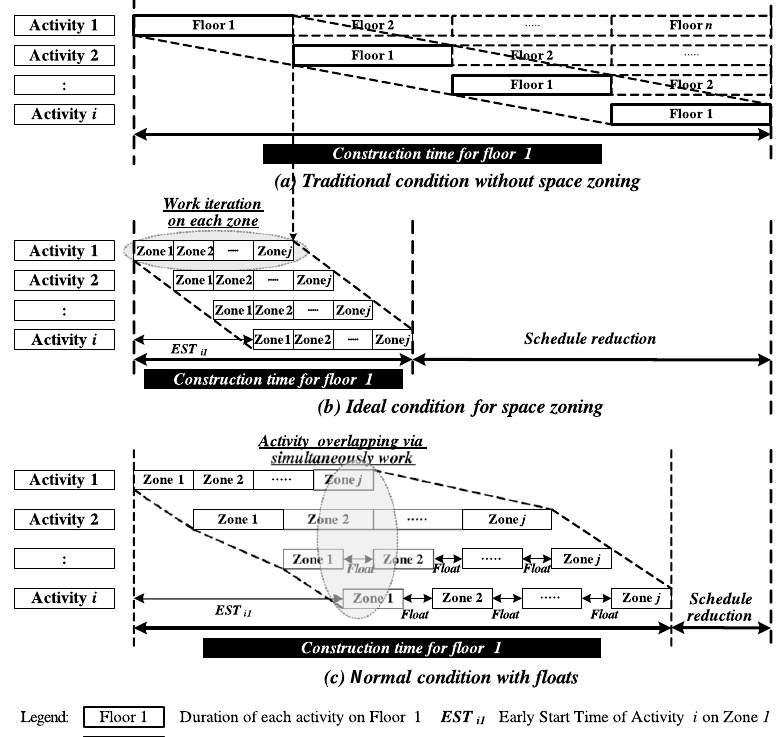
Fig. 1. Concept of space